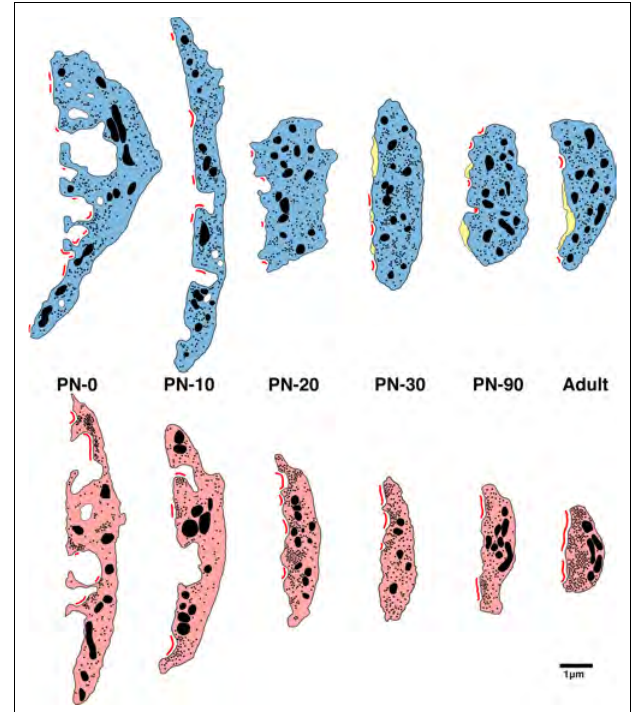
FIGURE 14 | Schematic of endbulb development in deaf (bottom) and normal hearing (top) cats. At birth in both cohorts, endbulb profi les have a convoluted membrane abutting the SBC which becomes less complex into adulthood. Endbulbs of deaf animals are in general smaller than normal. The number of PSDs (red) at birth in deaf animals is less than half that of normal. While mature endbulbs of both deaf and normal animals have the same number of PSDs, the PSDs of deaf animals are longer and fl atter than the normal convex PSDs. Deaf endbulbs exhibit an increase in synaptic vesicle (black dots) density near the PSDs. No remarkable differences were seen with respect to mitochondria (large black) size or volume fraction between the two groups. Endbulbs of normal cats begin to develop cisternae (yellow) around postnatal day 10 while deaf endbulbs never develop them to any notable degree.